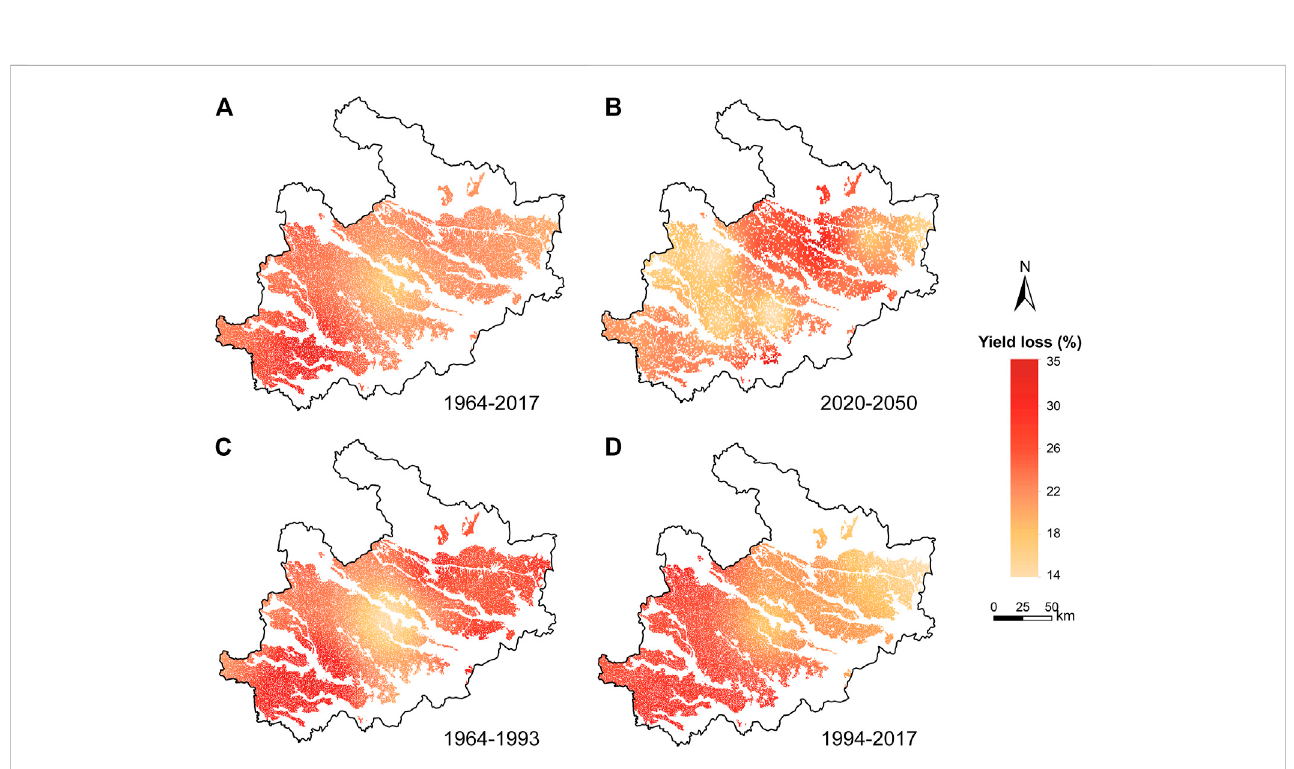
FIGURE 6 The average annual yield loss of summer maize in the years occurring DFAA events. (A) , during 1964 – 2017; (B) , during 1964 – 2017; (C) , during 1964 – 1993; (D) , during 1994 – 2017.